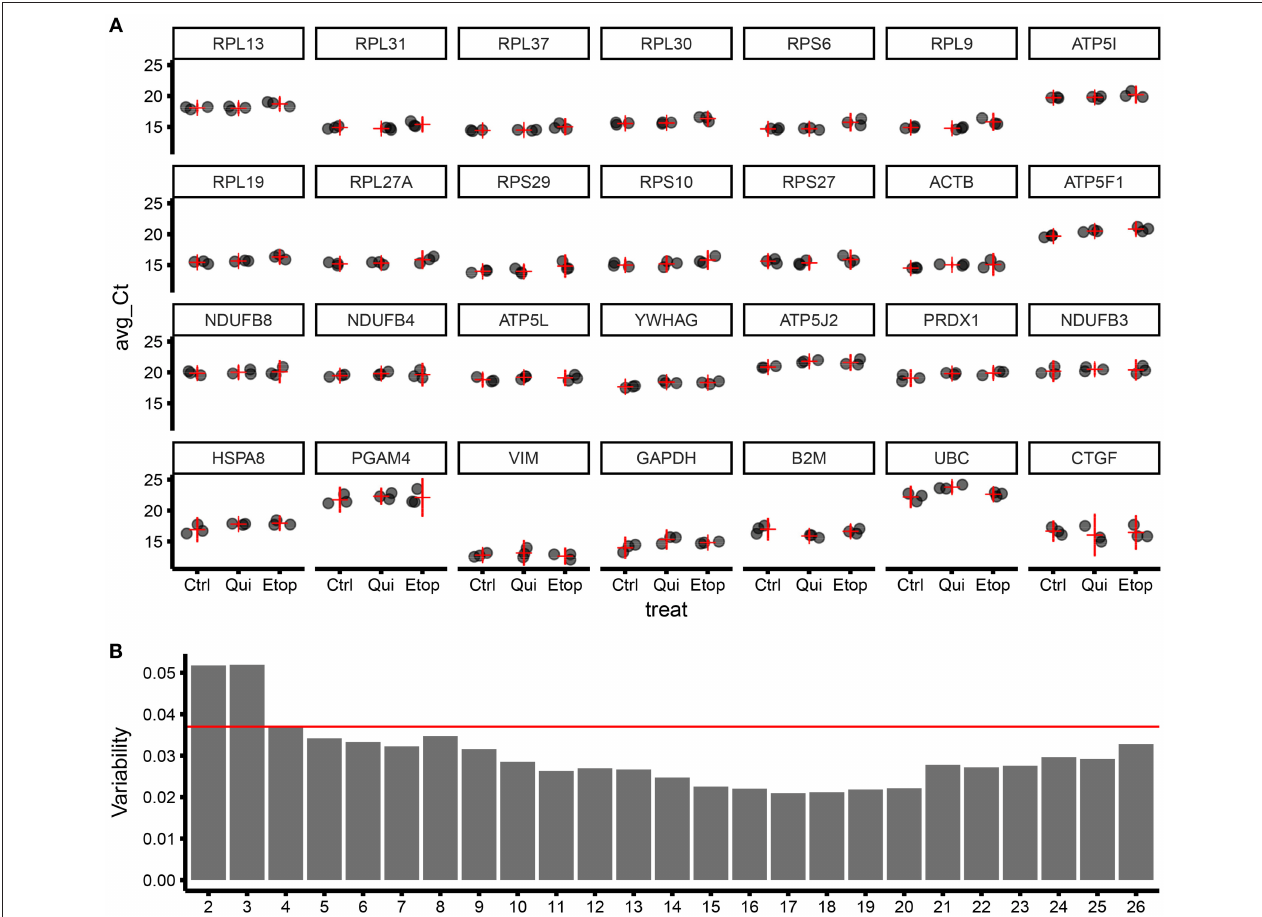
FIGURE 3 | Validation of gene stability from geNorm results using RT-qPCR for 28 candidate housekeeping genes. (A) Level of expression (qPCR) for different genes ordered by stability (starting from the most stable; by row; top to bottom), expressed as Ct of three biological replicates (for each biological replicate, three technical replicates were produced). The horizontal red line is the estimate of the average expression for the studied gene in the specific treatment group. The vertical red line is the 95% confidence interval of the estimate of the average expression. The variability within and between treatment increase moving from top-left to bottom-right. Ctrl, control ECFCs; Qui, quiescent ECFCs; Etop, Etoposide-induced senescent ECFCs. (B) Bar plot showing sample variability by the number of genes used for calculating the normalization factor